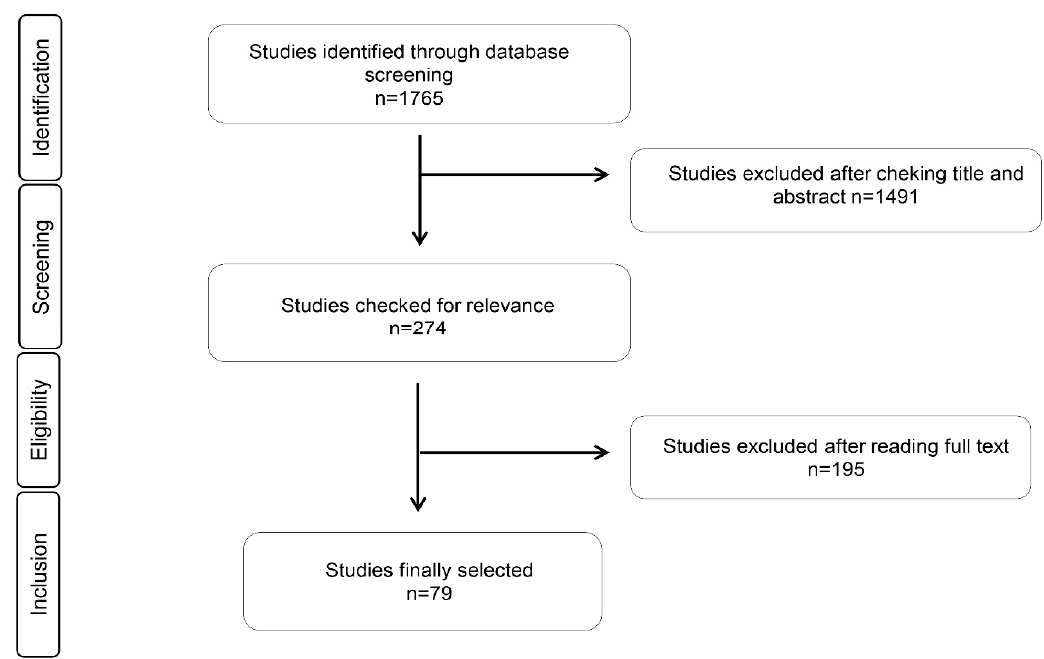
Figure 1. PRISMA flow chart for studies related with antibacterial, antioxidant, and immunomodulatory properties of essential oils.